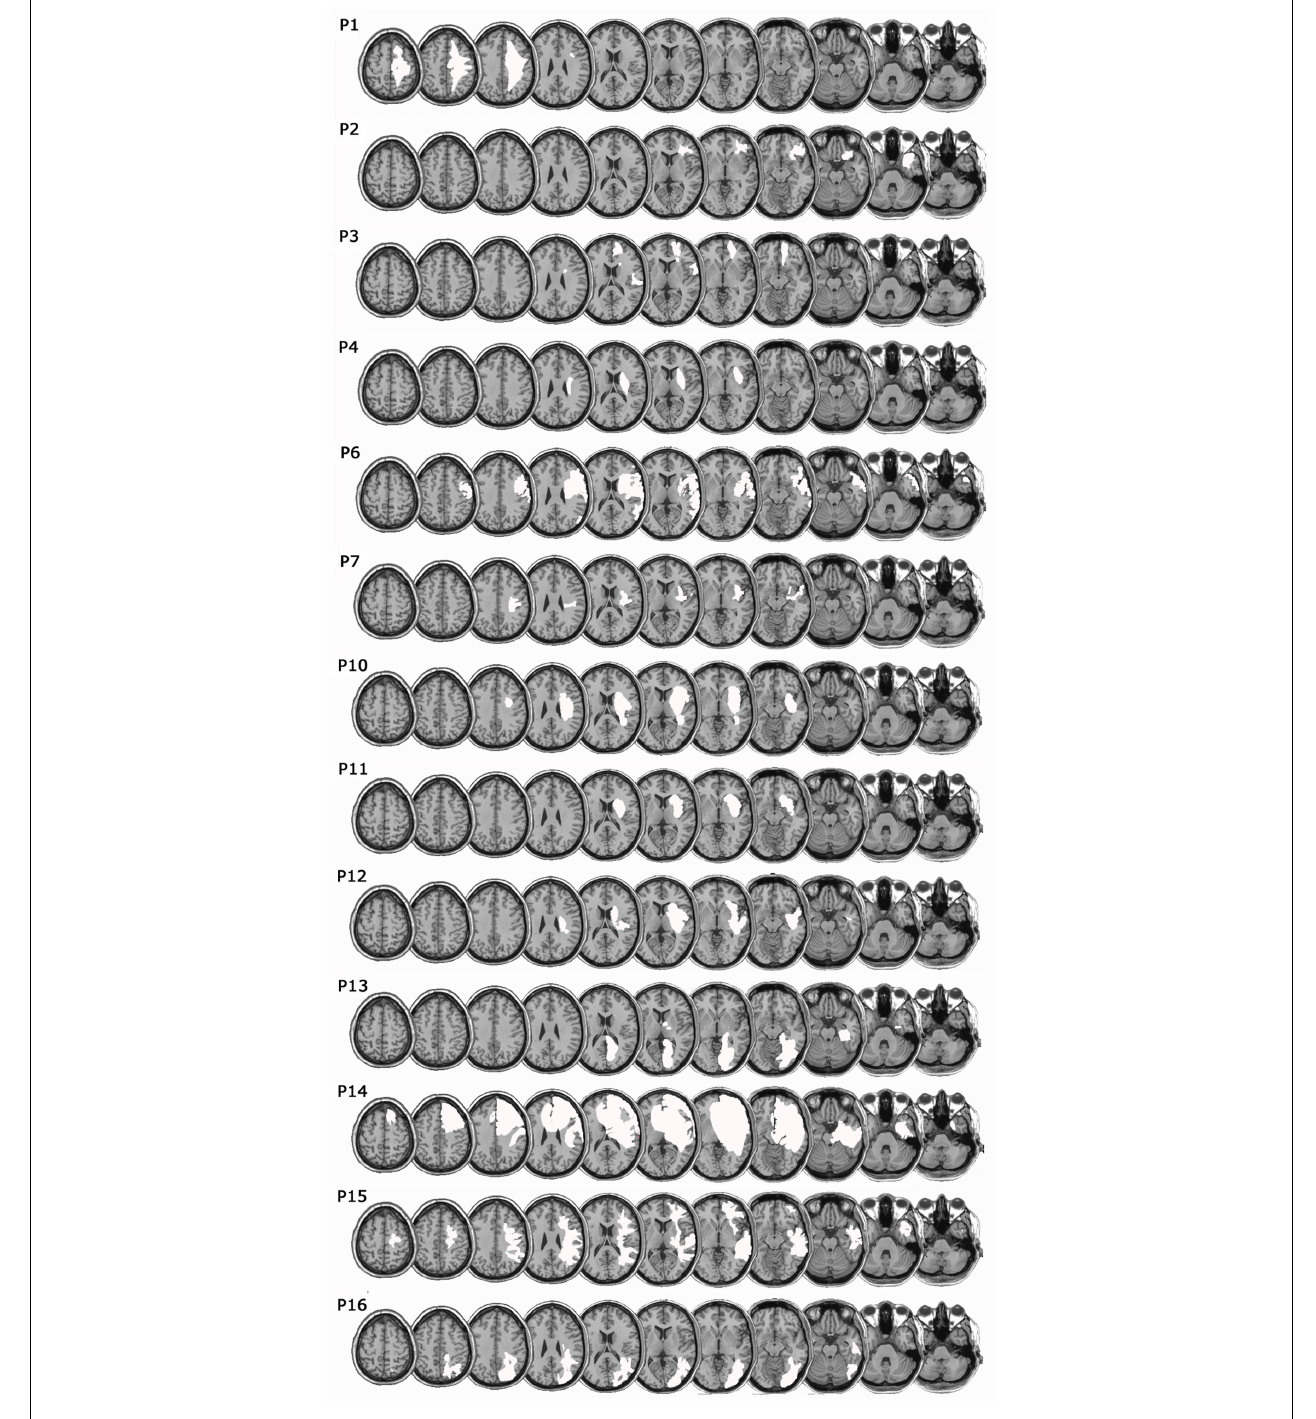
FIGURE 1 | Lesion mapping. Lesions were mapped onto a standard template (Montreal Neurological Institute) using the software MRIcro (Rorden and Brett, 2000).White areas represent the extension of the lesion of each patient.